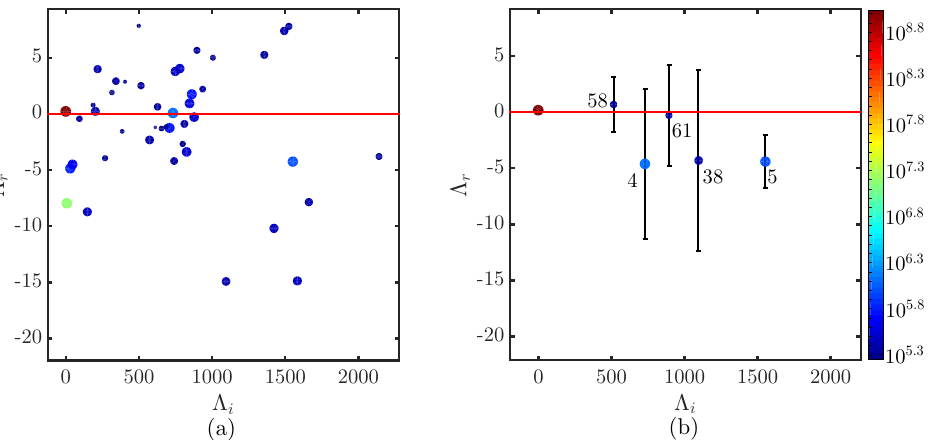
Figure 3. ( a ) The DMD spectrum for the reacting flow for a “lean” mixture with equivalence ratio φ = 0.8 (adapted from the Ref. [31]). The flow exhibits symmetric vortex shedding, as well as von Karman shedding at this equivalence ratio. ( b ) The mean and standard deviation for the robust modes 4, 5, 38, 58, and